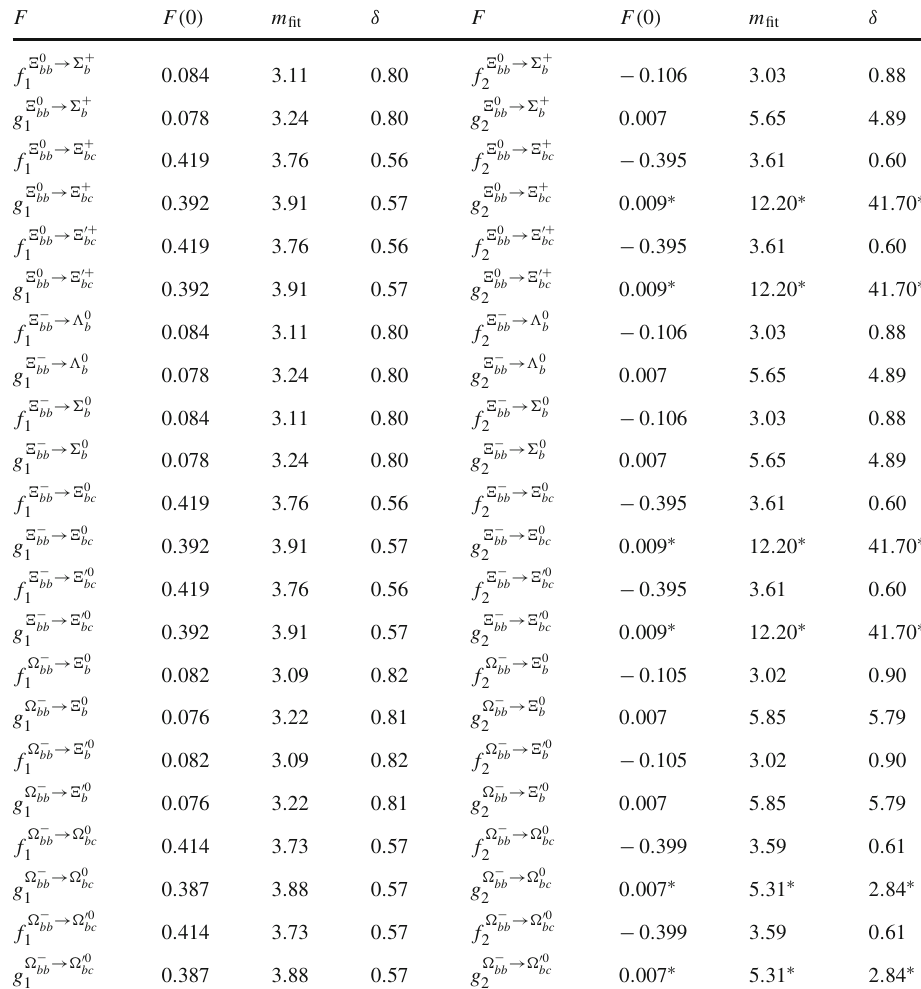
Table 10 Same as Table 8 but for the doubly bottom baryon decays with scalar (0 + )